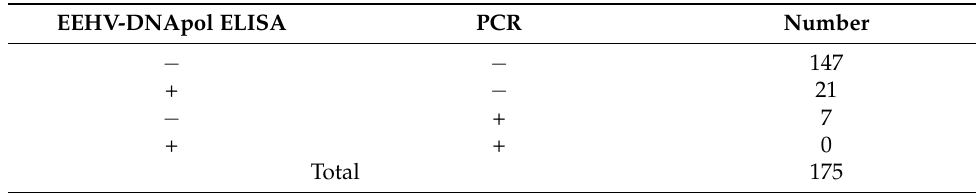
Table 4. Combined results for the detection of the antibody (ELISA) and viral genomic DNA (PCR) in 175